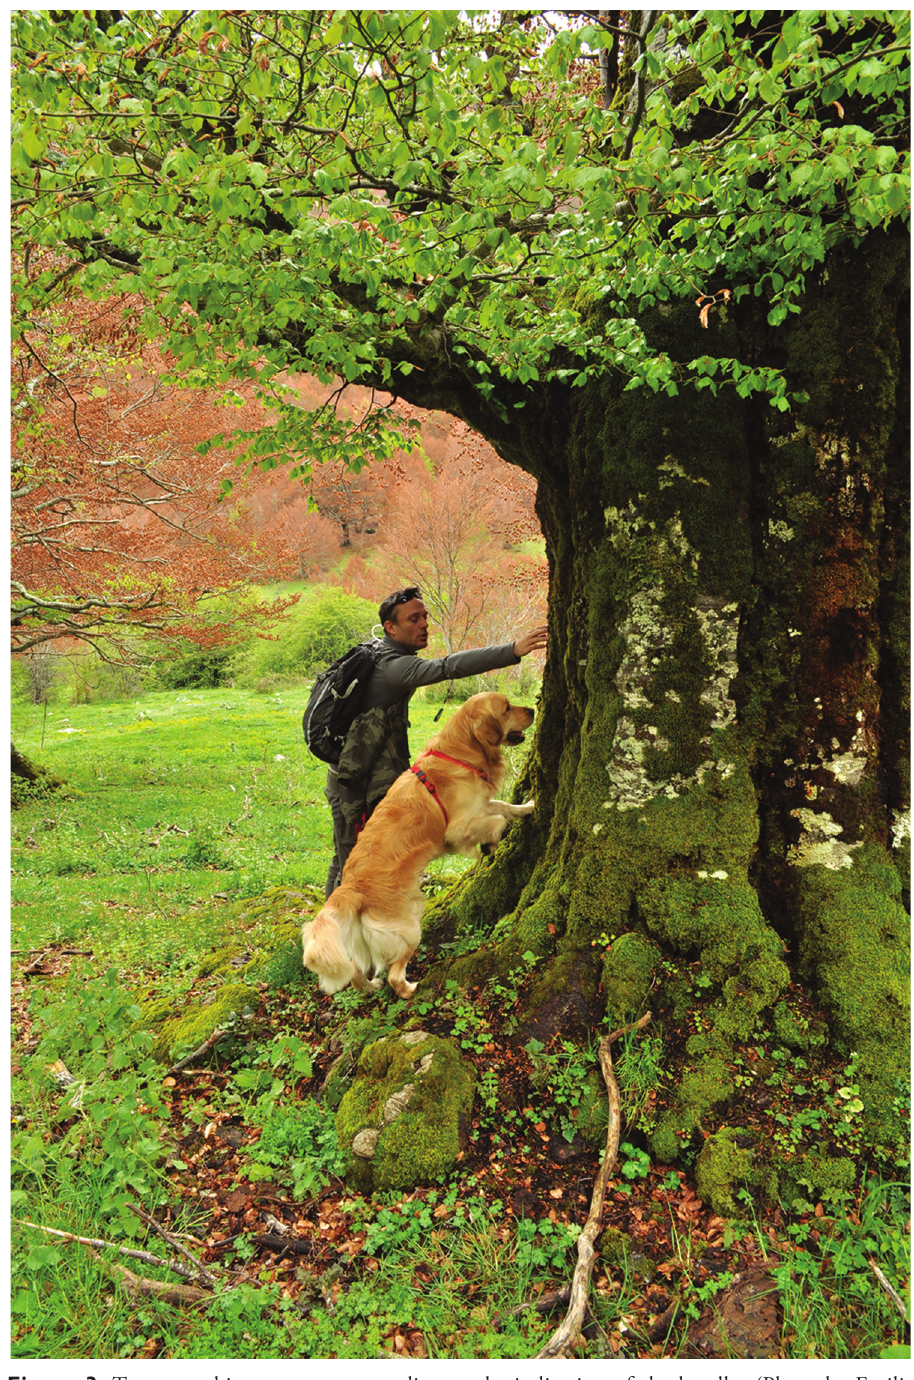
Figure 3. Teseo searching on a tree according to the indication of the handler (Photo by Emilia